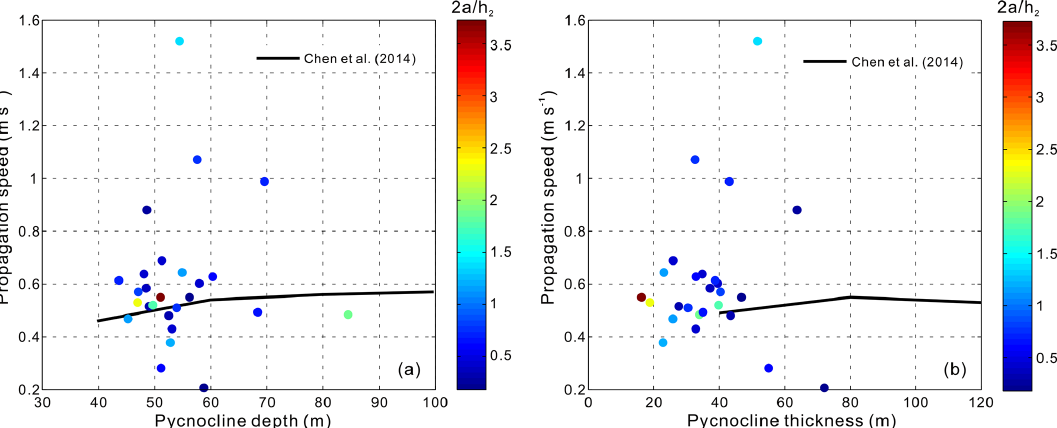
Figure 10. (a) Relationship between propagation speeds and pycnocline depths of the mode-2 ISWs observed in the study area. (b) Relation- ship between propagation speeds and pycnocline thicknesses of the mode-2 ISWs observed in the study area. The color-filled circles indicate the dimensionless